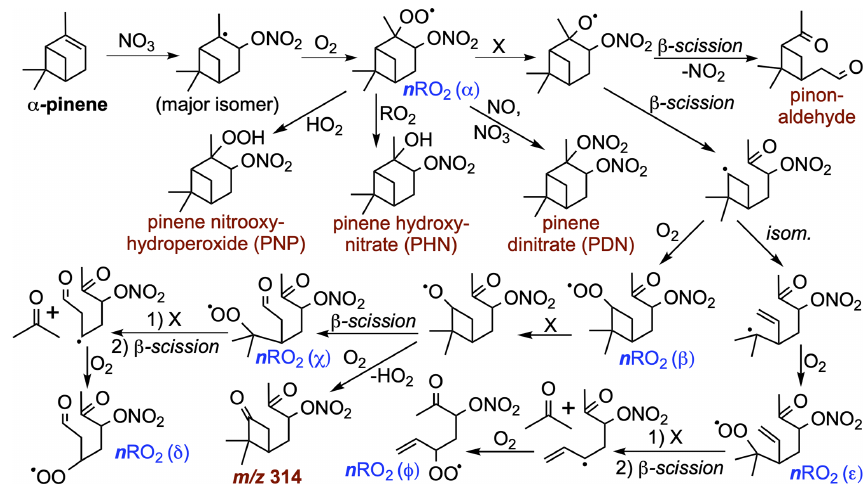
Figure 9. Proposed mechanisms for the formation of stable products (red) from α -pinene + NO 3 oxidation, including nitrooxy- hydroperoxide (PNP), α -pinene hydroxynitrate (PHN), pinene dinitrate (PDN), the oxidation product observed by CIMS at m/z 314, and pinonaldehyde, as well as α -pinene-derived peroxy radicals ( n RO 2 α - ϕ , blue) that may contribute to particle-phase dimers (Fig. 10) following the dominant secondary addition of NO 3 to α -pinene. “X” stands in for any of RO 2 , HO 2 , NO, or NO 3 as bimolecular reaction